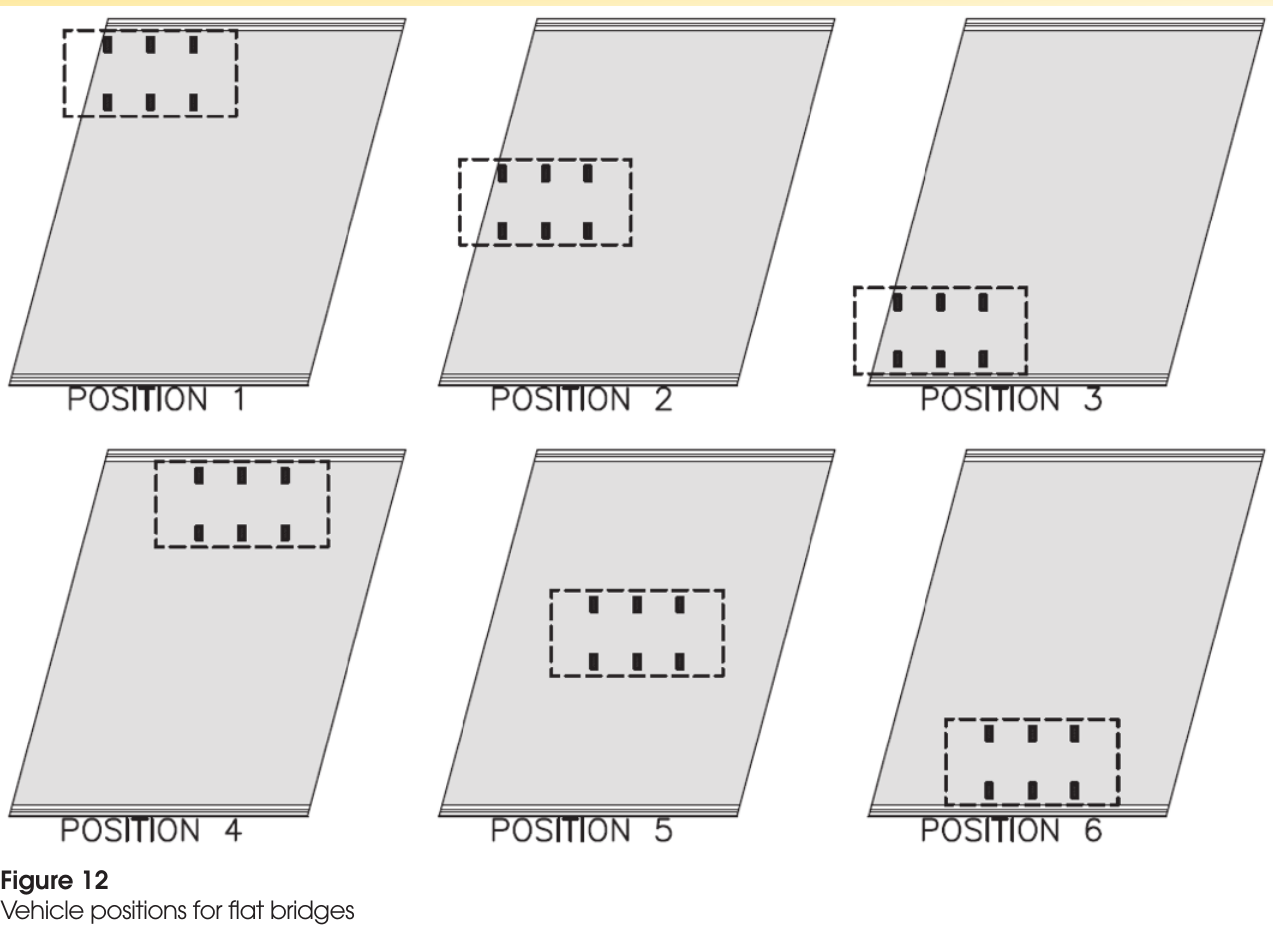
Vehicle positions for flat bridges